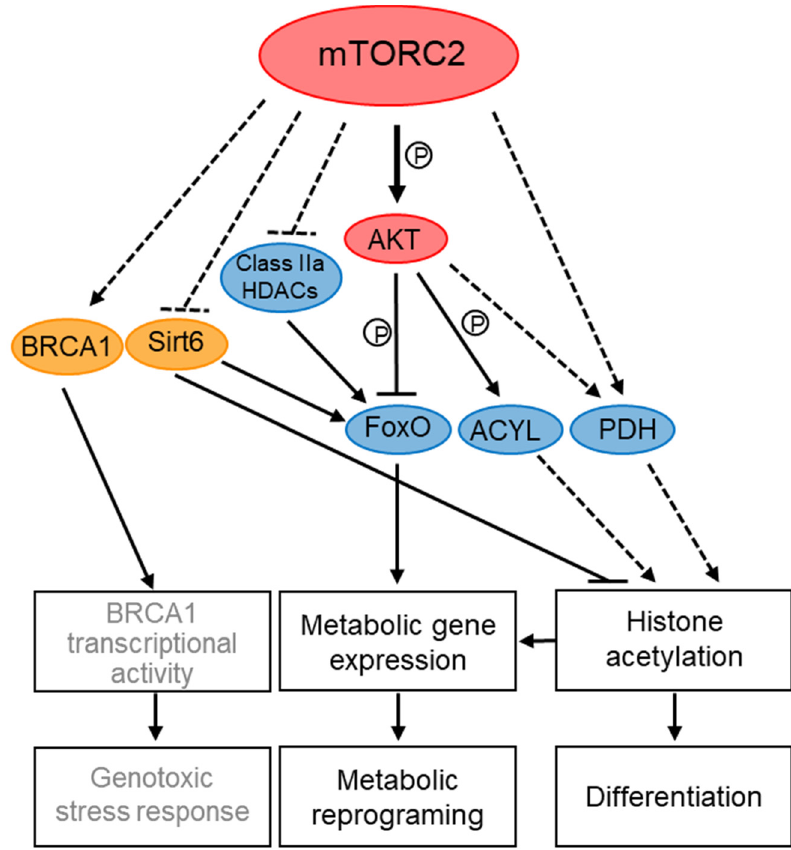
Figure 3. Roles of the mTORC2 complex in transcriptional and epigenetic regulation. Dashed arrows indicate regulation that is either indirect, or not yet known to be direct. Solid lines indicate direct regulation. P denotes phosphorylation. Yellow circles indicate proteins that physically interact with mTORC2. Blue circles indicate proteins that are regulated by mTORC2 or AKT outside of the nucleus. The link between mTORC2 and BRCA1 (grey letters) is more recent and yet to be tested more rigorously.